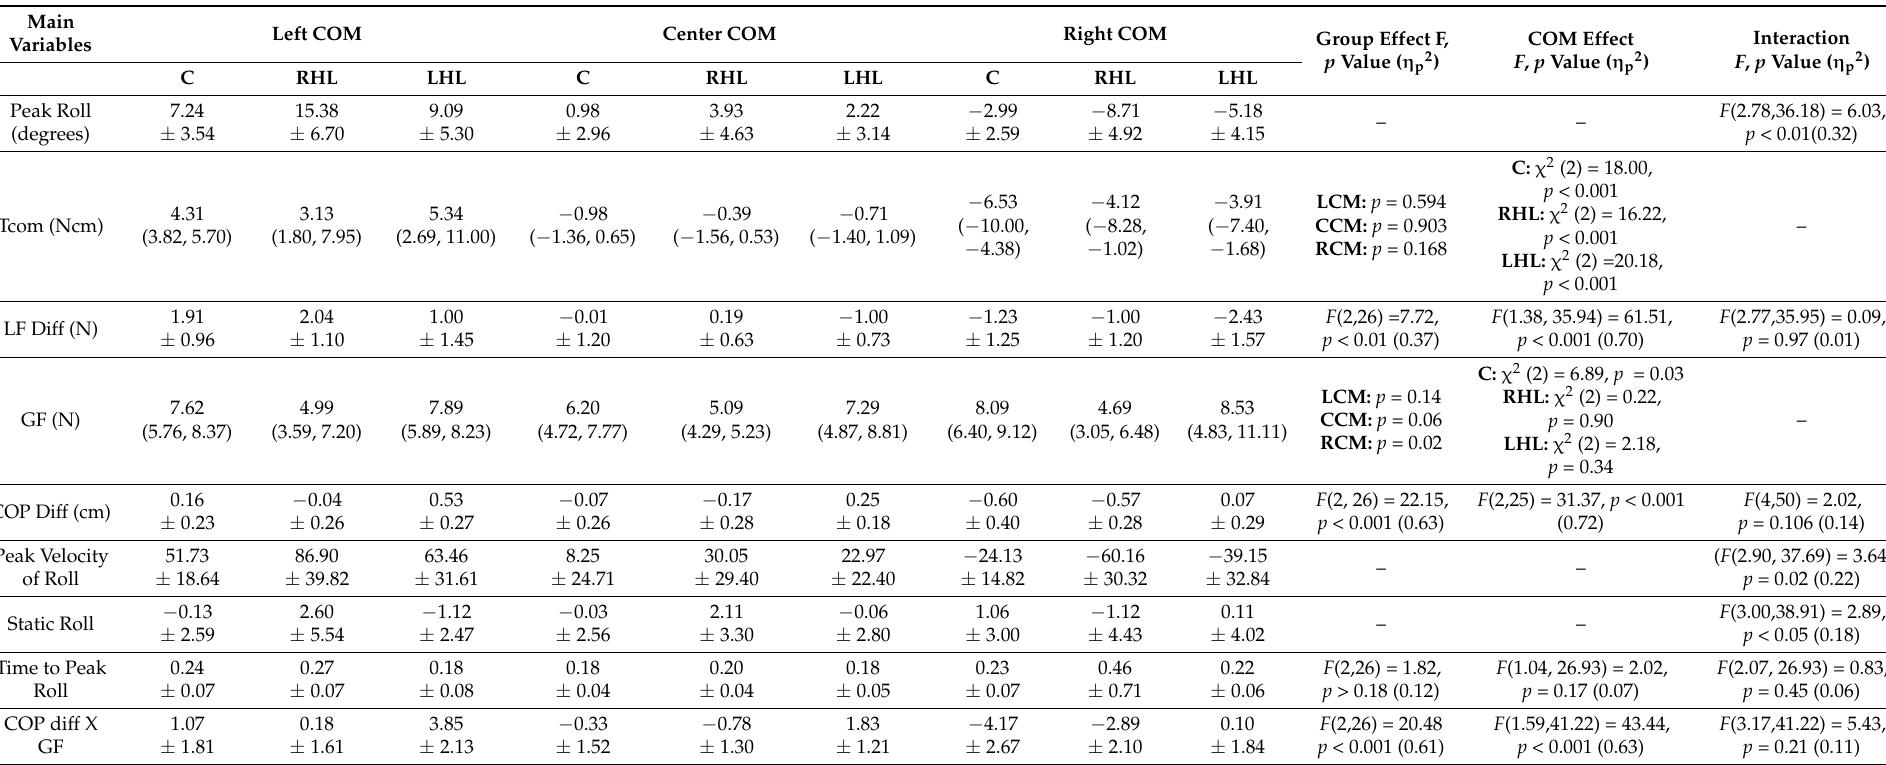
Table 2. Mean and standard deviations of each variable for each group for each center of mass. p values for the interaction, group and center of mass main effects. Median, interquartile range, chi squared and p values for non-parametric variables (Tcom and GF). Tcom = compensatory torque; LF diff = load force difference; GF = grip force; COP diff = center of pressure difference; C = controls, RHL = right hemisphere lesion; LHL = left hemisphere lesion; LCM = left center of mass, CCM = centered center of mass, RCM = right center of